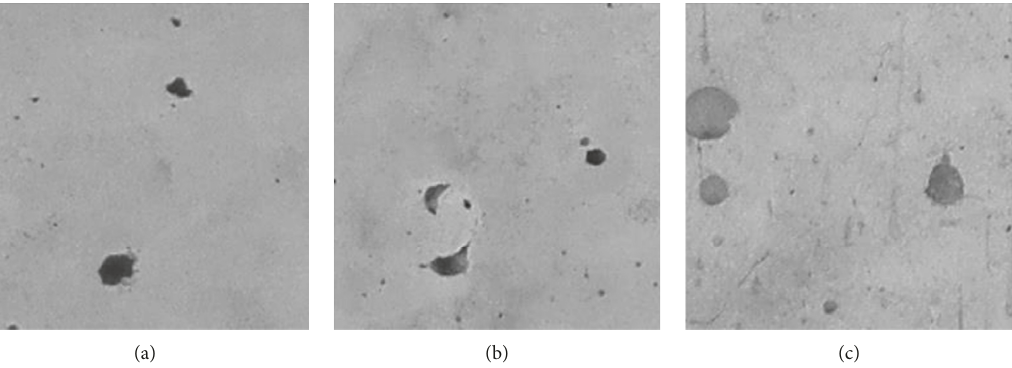
Figure 2: Concrete surface bughole images.